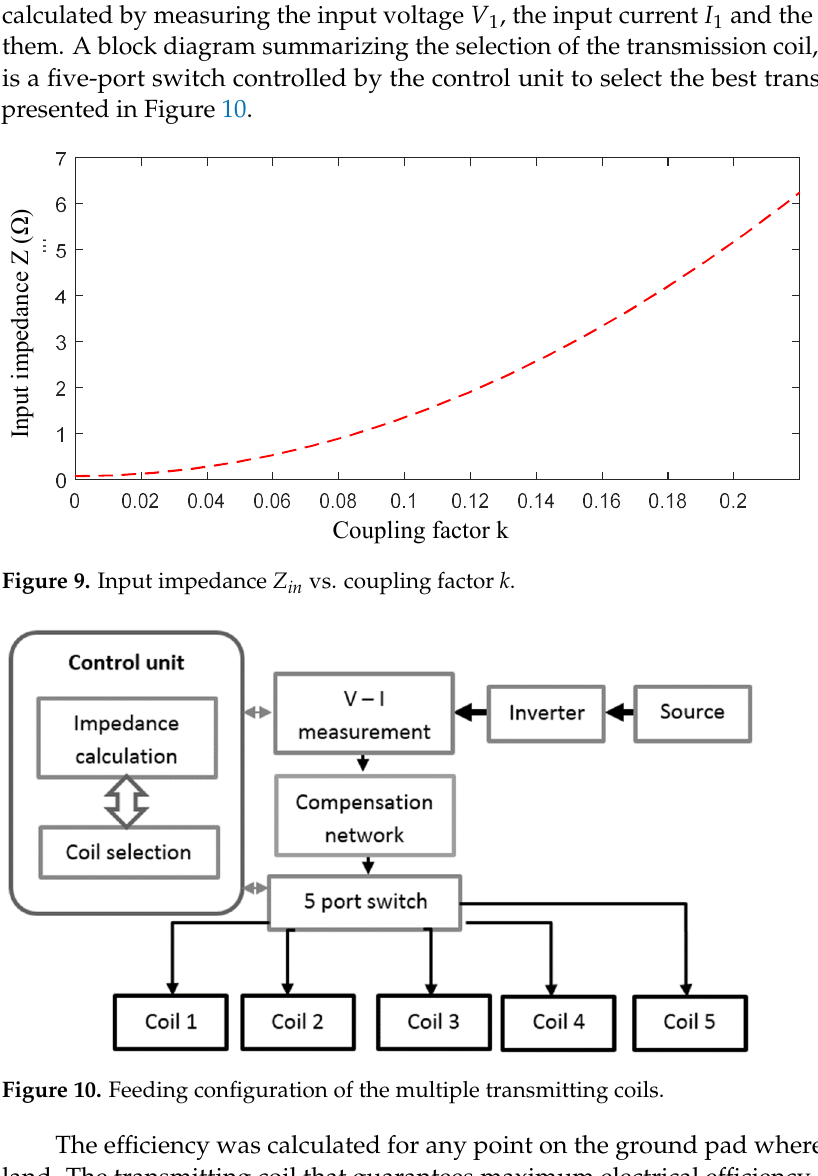
Figure 10. Feeding configuration of the multiple transmitting coils.